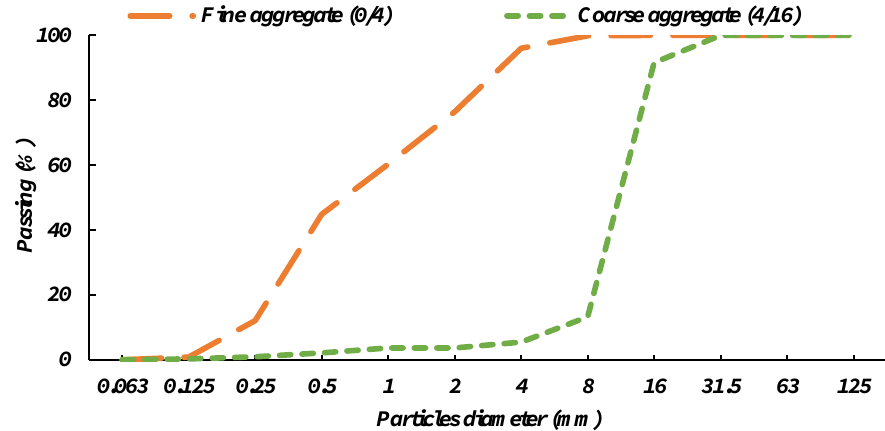
Figure 1. Grading curves of sand, quartz coarse aggregate, and expanded clay LWA.